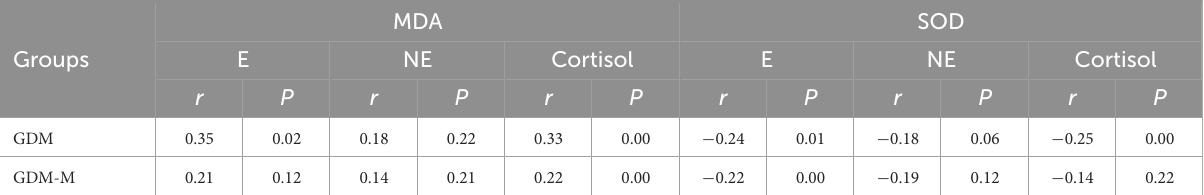
TABLE 3 Correlation of stress hormones with MDA and